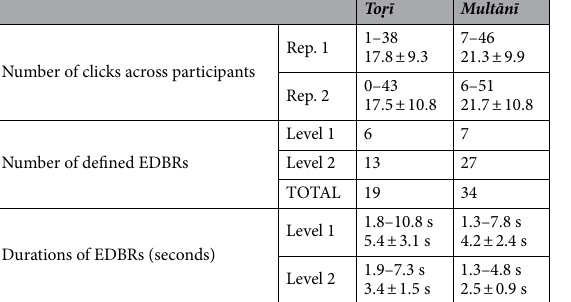
Table 2. Descriptive statistics regarding the number of inserted clicks, and number and duration of defined EDBRs. Number of clicks and EDBR durations are indicated as range and mean ± SD. Rep ., repetition (listening)